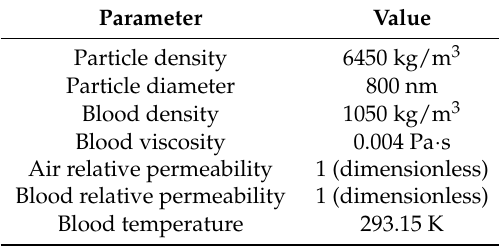
Figure 3. Steering aggregated magnetic nanoparticles (MNPs) in a Y-shaped channel using magnetic actuation. Table 1. Simulation